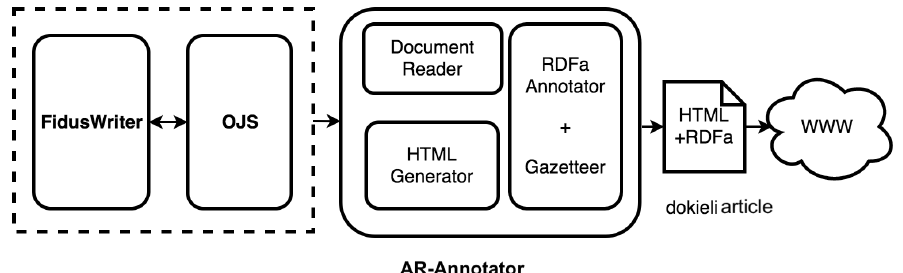
Figure 1. A pipeline for scholarly article authoring, reviewing and publishing facilitated by an